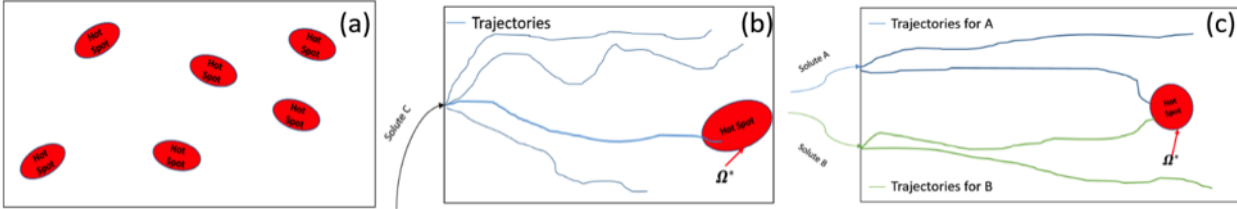
Figure 1. Identified categories of HSHMs. Panel (a) presents HSHMs resulting from a type-A (static) indicator only; panel (b) presents HSHMs resulting from coupled action (static + dynamic), and panel (c) presents HSHMs resulting from multiple (two) dynamic